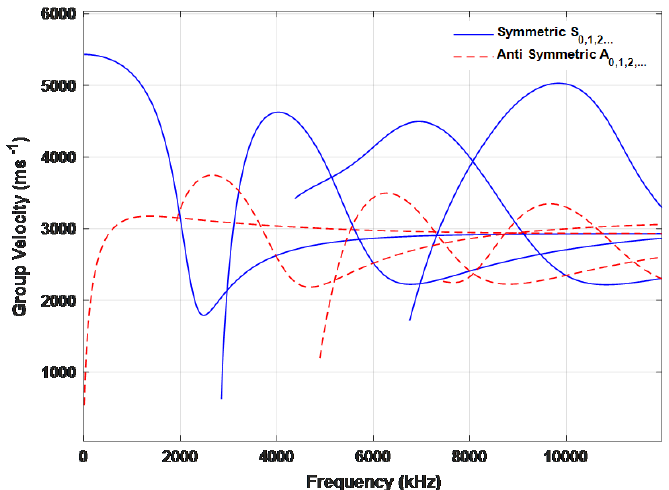
Figure 4. Dispersion curve of the Lamb wave of a 2 mm thick aluminum plate.